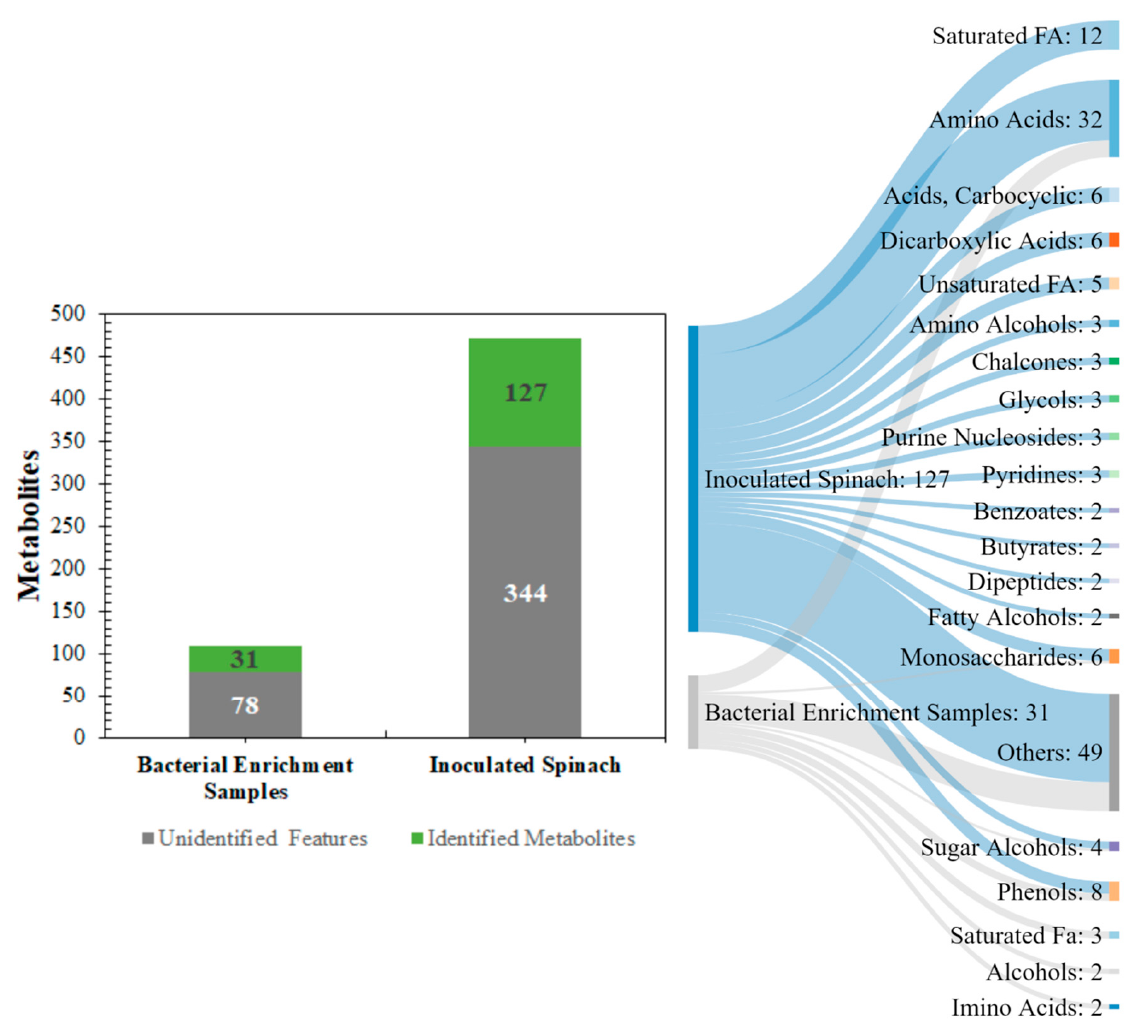
Figure 1. A global overview of the metabolic profiling outputs from the pathogenic E. coli experiments in buffered peptone water (BPW) cultures ( n = 36) and inoculated spinach experiments ( n = 58). The number of identified metabolites has been highlighted in green and the number of unidentified metabolites has been highlighted in grey.